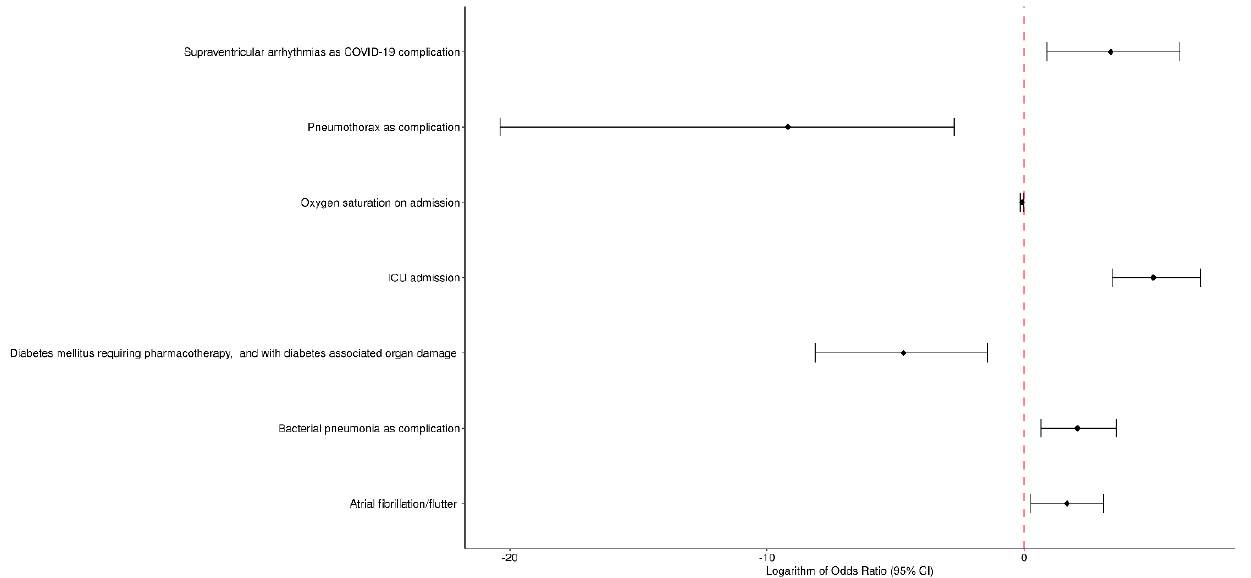
Figure 2. Multivariate logistic regression model analysis of the factors independently associated with death during the first COVID-19 wave in the Hospital for Infectious Diseases in Warsaw (Poland).